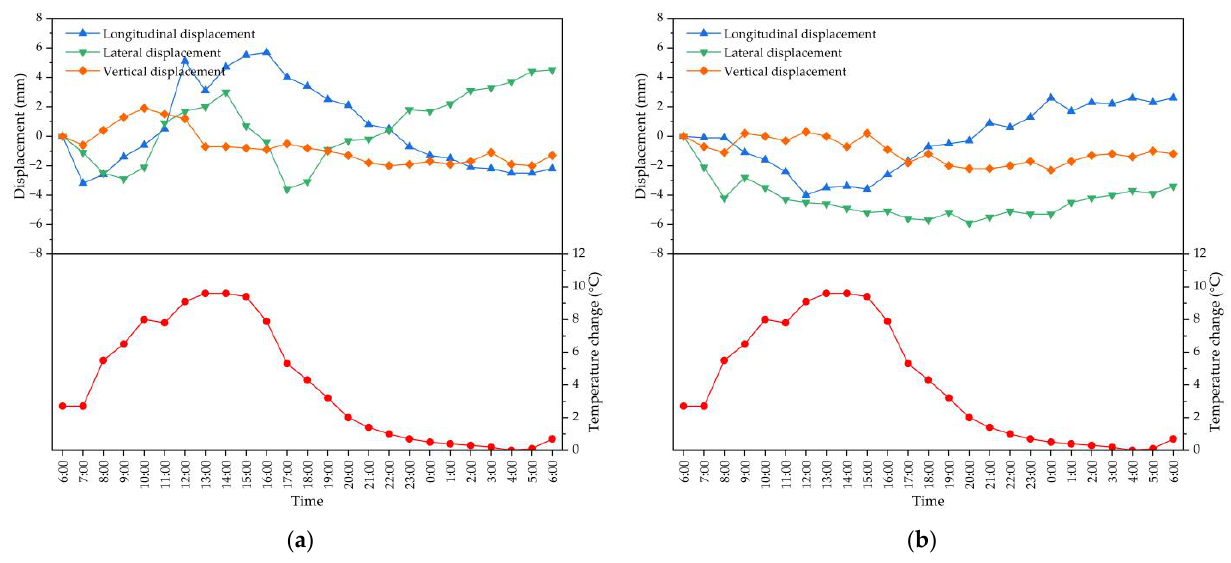
Figure 14. Continuous temperature and deformation monitoring of segment N4 for arch rib: ( a ) at Nanning side; ( b ) at Beihai side.